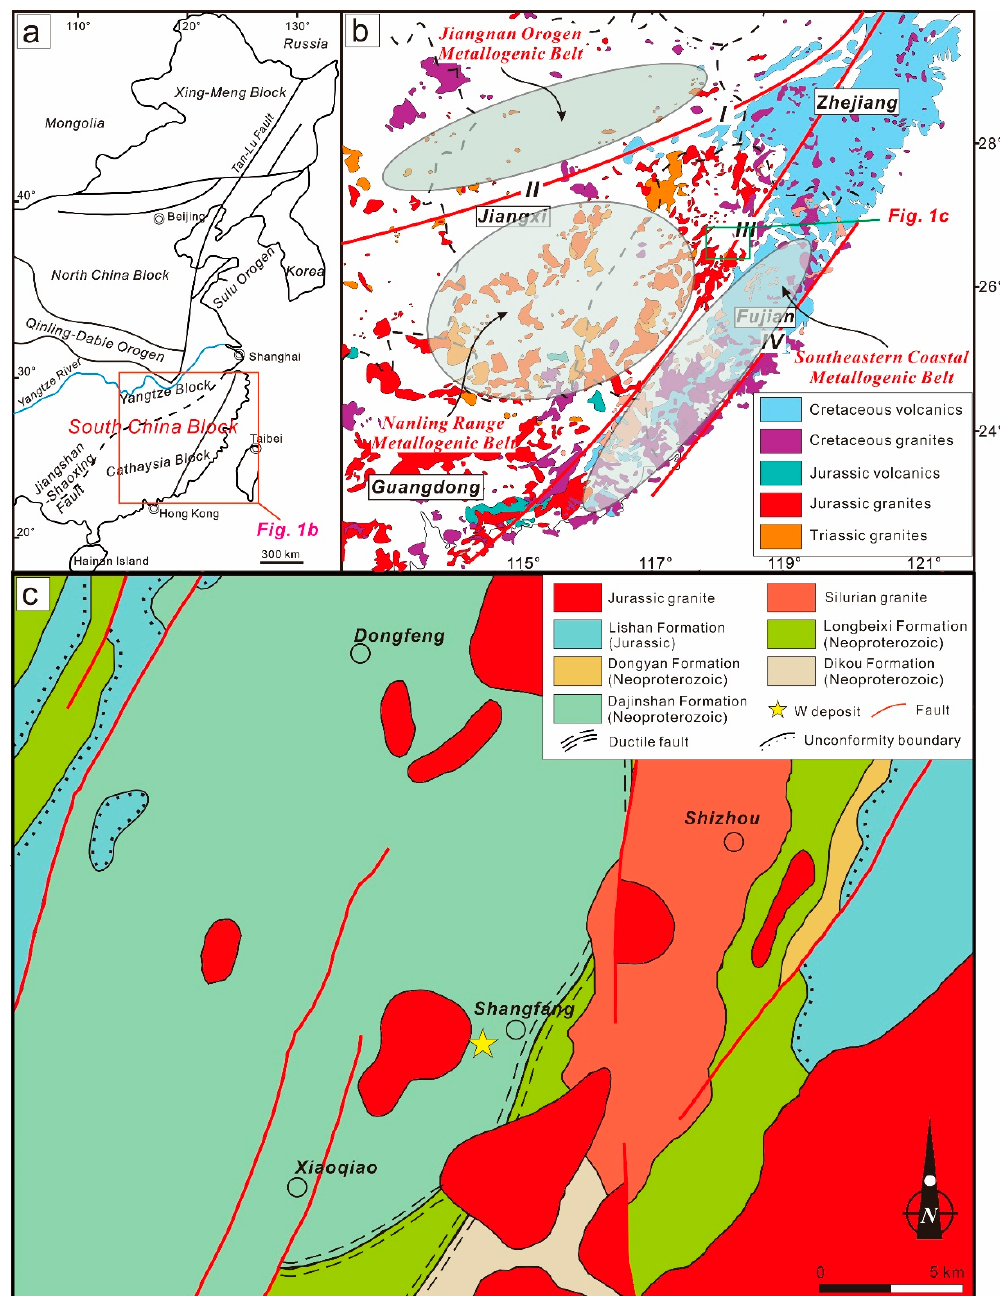
Figure 1. ( a ) Tectonic scheme of eastern China; ( b ) schematic map of SE China showing the distribution of the Mesozoic granitic and volcanic rocks (modified from Zhou et al. [22] ); ( c ) geological map of the Dongfeng ‐ Xiaoqiao region showing the location of the Shangfang W deposits. I ― Jiangshan ‐ Shaoxing fault; II ― Pingxiang ‐ Yushan fault; III ― Zhenghe ‐ Dapu fault; IV ― Changle ‐ Nan’ao fault.